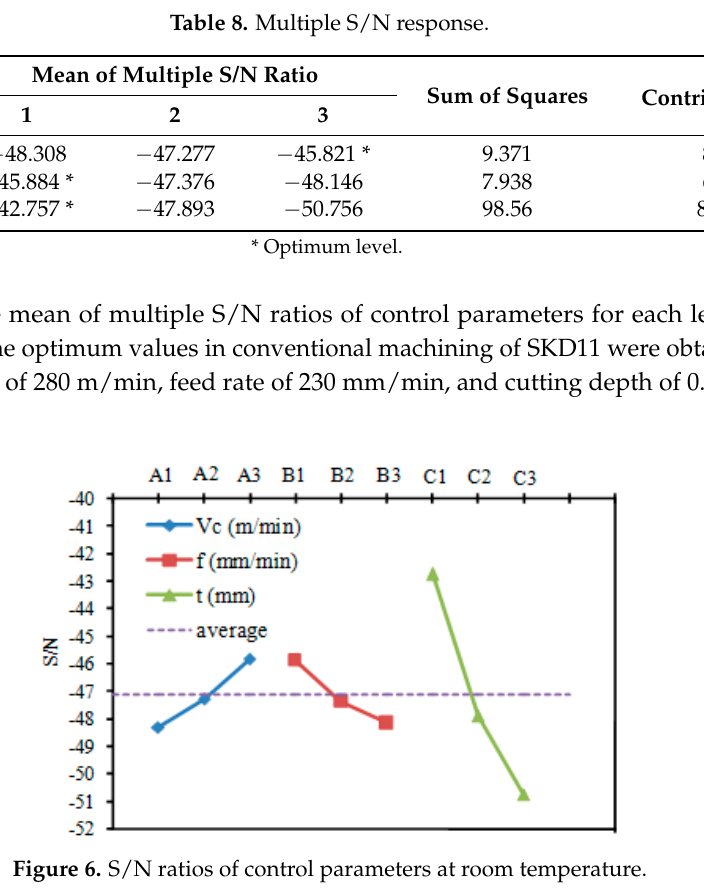
Table 9. Multiple S/N response.